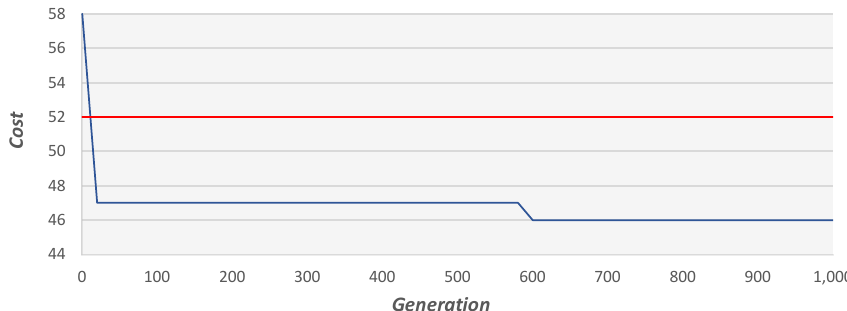
Figure 26. The cost reduction of the GA over 1000 generations on an example problem. The fixed red line represents the result of the 2-factor approximation method.